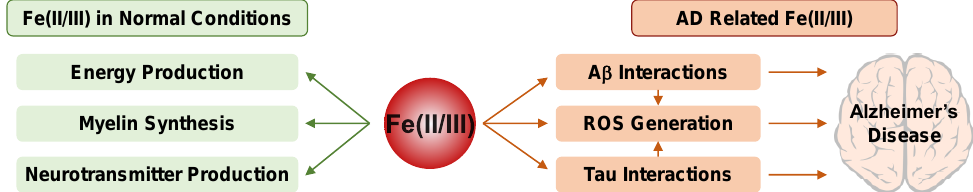
Figure 3. The roles and effects of Fe(II/III) in normal (left) and AD-affected (right) brains.